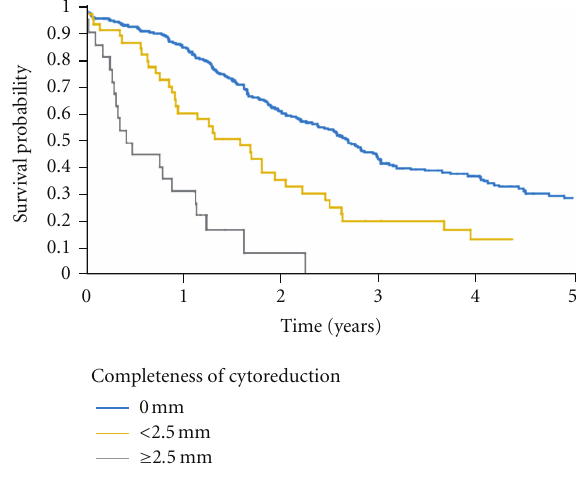
Figure 1: Prognostic impact of the completeness of cytoreductive surgery ( P < 0 . 001) on overall survival